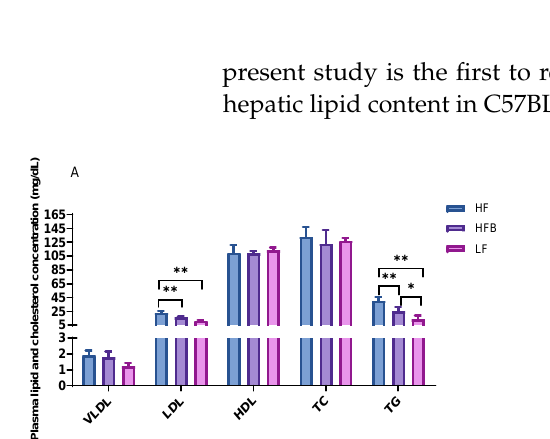
Figure 1. ( A ) Plasma lipid and cholesterol level in mice fed high-fat (HF) diet, high-fat diet containing 20% cooked black turtle bean (HFB) and low-fat (LF) diet for 6 weeks. ( B ) Hepatic total lipid content in mice fed with high fat (HF) diet, high-fat diet containing 20% cooked black turtle bean (HFB) and low-fat (LF) diet for 6 weeks. VLDL: very low-density lipoprotein; LDL: low-density lipoprotein; HDL: high-density lipoprotein; TC: total cholesterol; TG: triglyceride. * p < 0.05, ** p < 0.01 between groups.